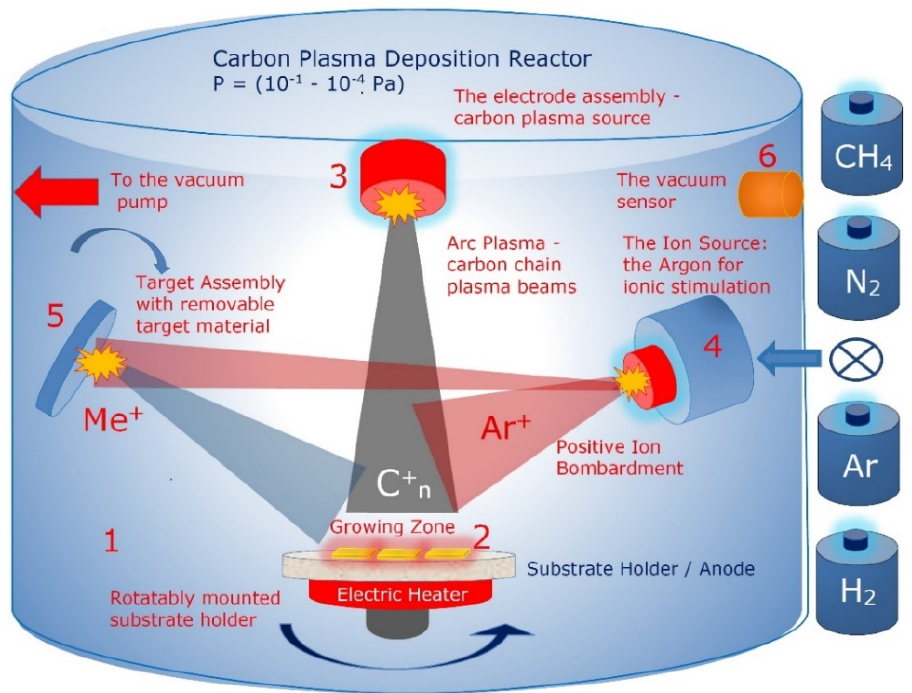
Figure 5. Schematic representation of the pulse-plasma deposition reactor for growing the 2D-ordered linear-chain carbon nanomatrix: 1—vacuum chamber; 2—substrate; 3—pulse-plasma carbon generator (graphite cylindrical main discharge cathode); 4—the ion source for ionic stimulation; 5—target assembly with removable target material; 6—vacuum sensor.